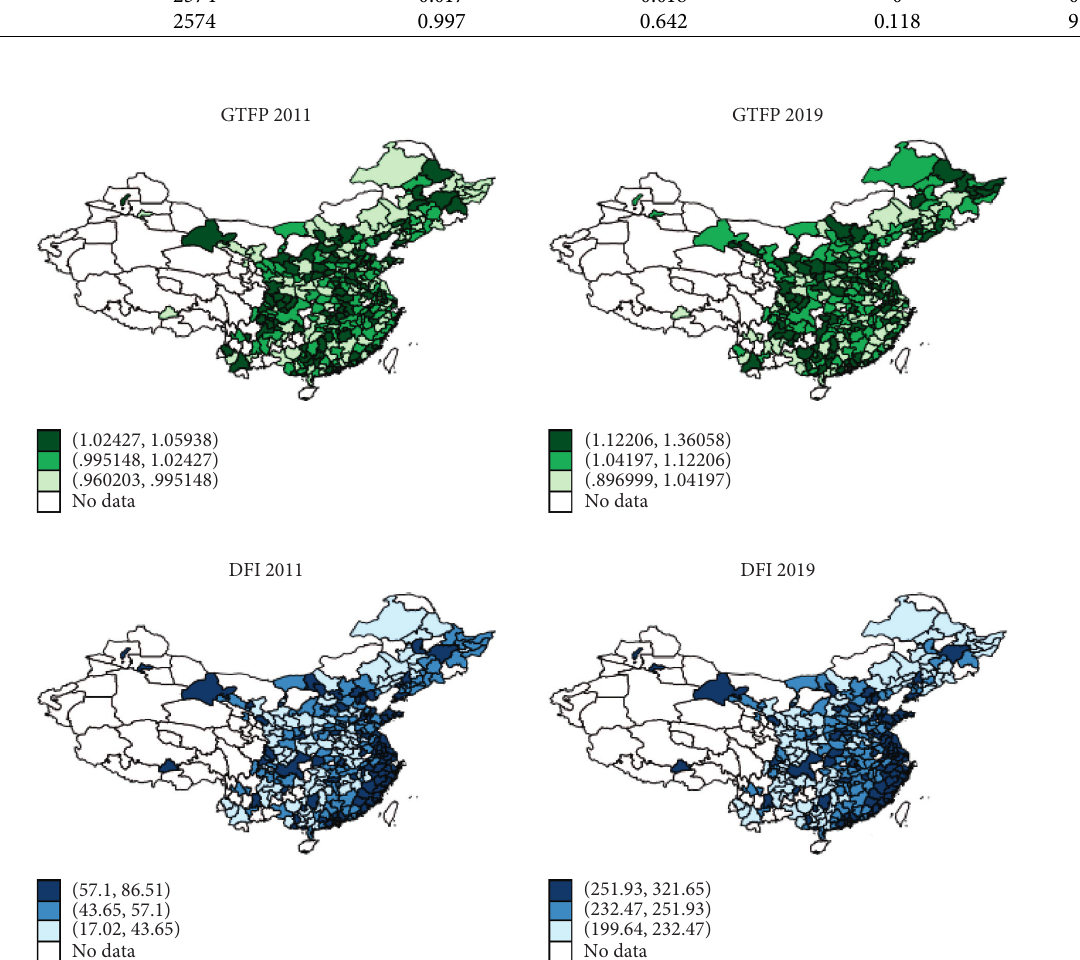
Figure 1: Spatial and temporal evolution of green development and digital finance.